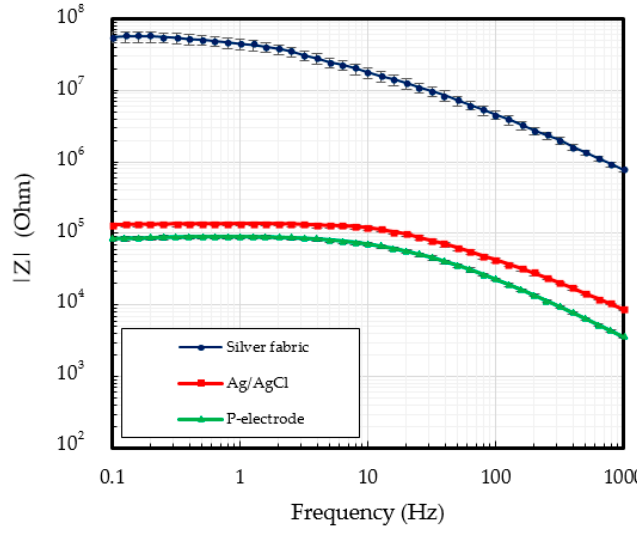
Figure 7. Contact impedance of the silver fabric, Ag/AgCl, and P-electrode.